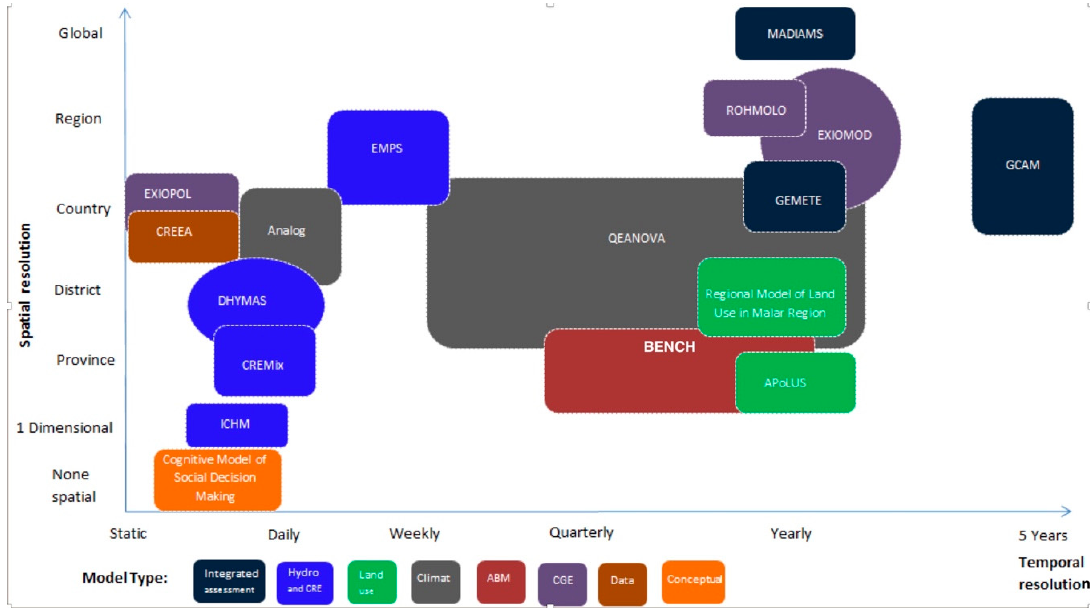
Figure 2. The COMPLEX project model space (see project web site for more details about particular models). For further information on models and classifications see [38].